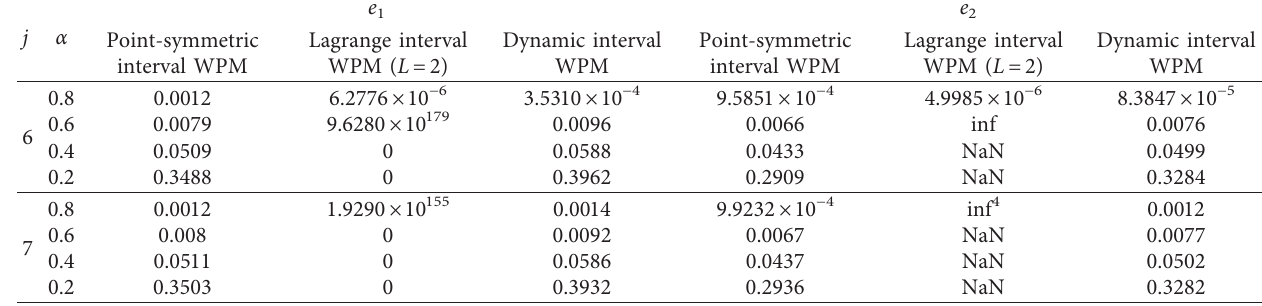
Table 2: Influence of α on the numerical precision ( t � 0.0001, T � 0.1).